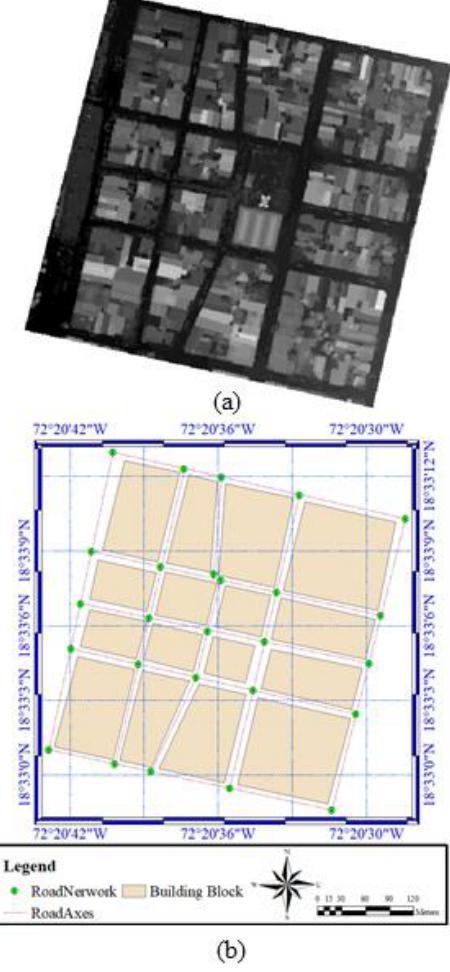
Figure 3. (a) Selected test area for evaluation of the proposed method. (a) The post-event LiDAR raster data (b) The roads network layer from the pre-event vector